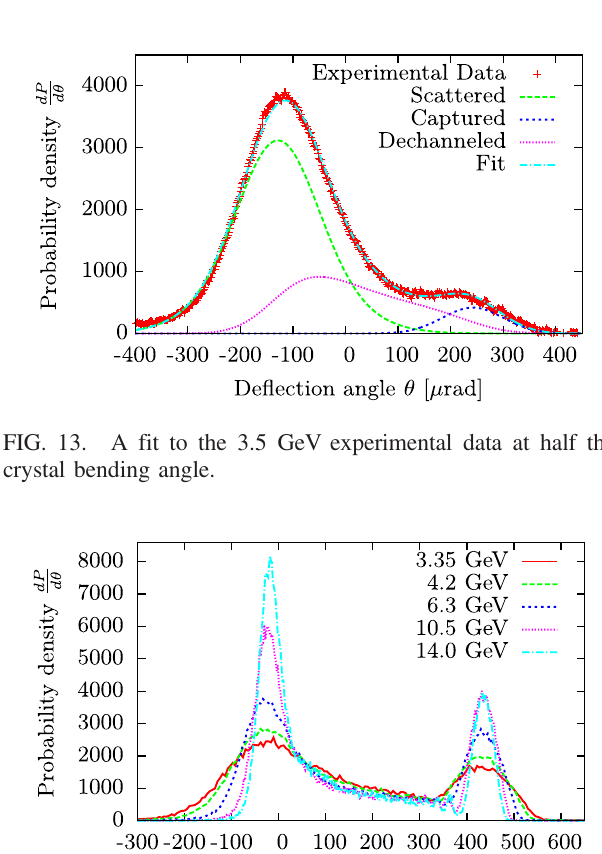
FIG. 14. The probability density of the deflected particles obtained from the DYNECHARM simulation when the crystal is in the channeling orientation for the different energies in the experiment.